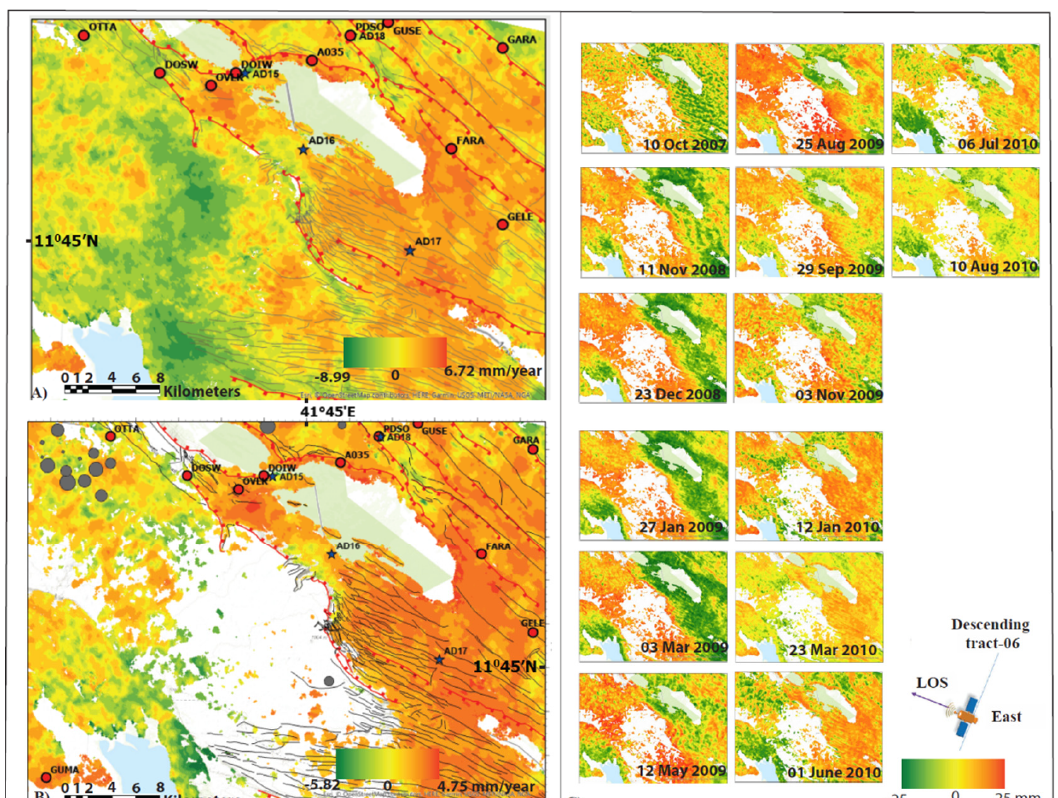
Figure 9. ( A ) The mean velocity at the LOS of the satellite for the descending tract 006, before post-GIS processing utilizing those quality control indexes mentioned in Figure 5 for pixel multitemporal coherency; ( B ) The mean velocity at the LOS of the satellite after extracting the noisy pixels employing the quality control indexes criteria; ( C ) Time-series displacement measurement corresponding to the measurement (in mm/year) of each scene with respect to the 9 January 2007 master image acquisition. The different colors and symbols represent displacement (in mm/year) along the LOS. See supplement S5.